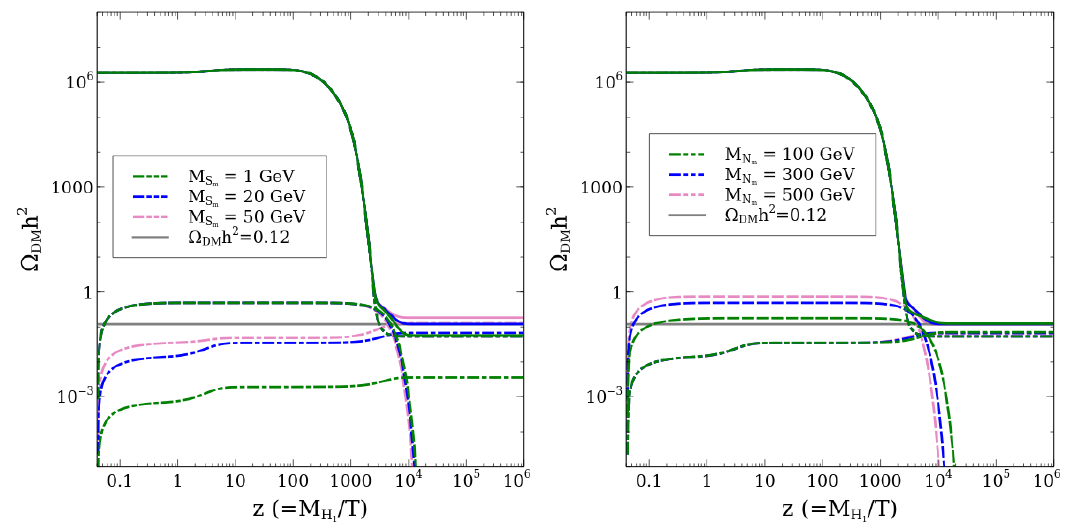
Figure 9 . Dependence of the DM relic densities on three different values of the FIMP DM mass (left) and the NLSP mass (right). The other parameters are chosen as M = 1 . 04628 GeV, W D Λ = 5 . 5 × 10 14 GeV, κ = κ 0 = ξ = ξ 0 = α = α 0 = 1 , M = 2 . 212 GeV, g = 3 . 1 × 10 − 4 , δ = 10 − 2 , H 2 D and sin α = 8 . 17 × 10 − 2 . For the reheating temperature, we have used T = 3 TeV. For the left plot, R = 300 GeV is chosen, while M = 20 GeV is used for the right plot. The double-dot-dashed M N S m m (dot-dashed) lines represent the WIMP (FIMP) DM relic densities, while the dashed lines indicate the NLSP relic densities. The solid lines are the sum of the FIMP and WIMP DM relic densities, while the grey solid line denotes the current DM relic density of